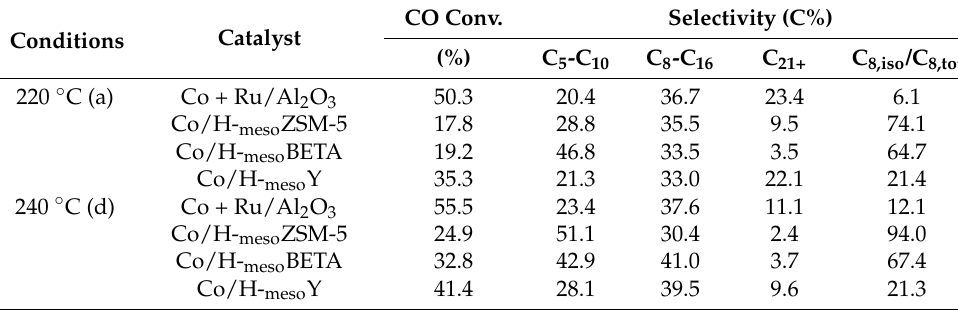
Table 4. Product distribution determined from the FTS